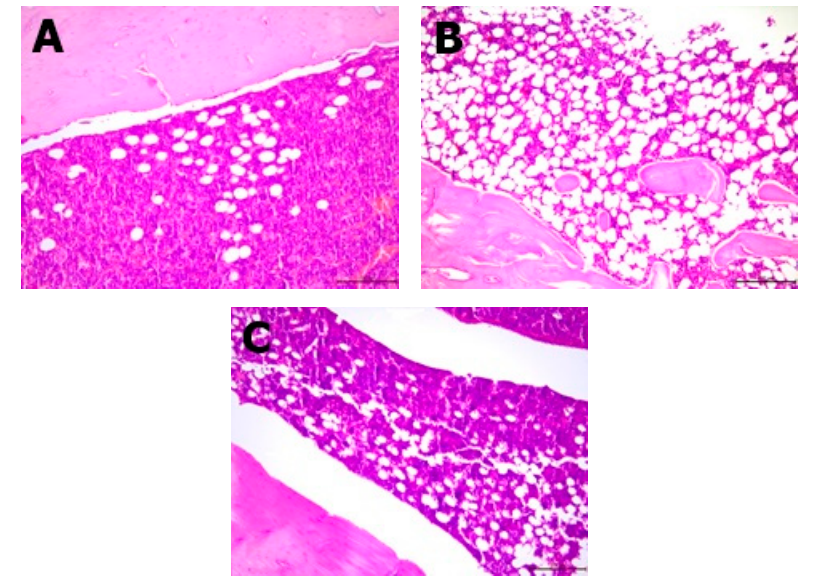
Table 3. Percentage of bone marrow femoral adipocytes and the number of osteoblasts (mean and standard deviation). Figure 3. Differences between the number of osteoblasts. ( A ) Few osteoblasts along the bones of the representative of the OVX group (H&E; 10×); ( B ) numerous clusters of osteoblasts arranged along the bones of the representative of the OVX-D group (H&E; 40×).